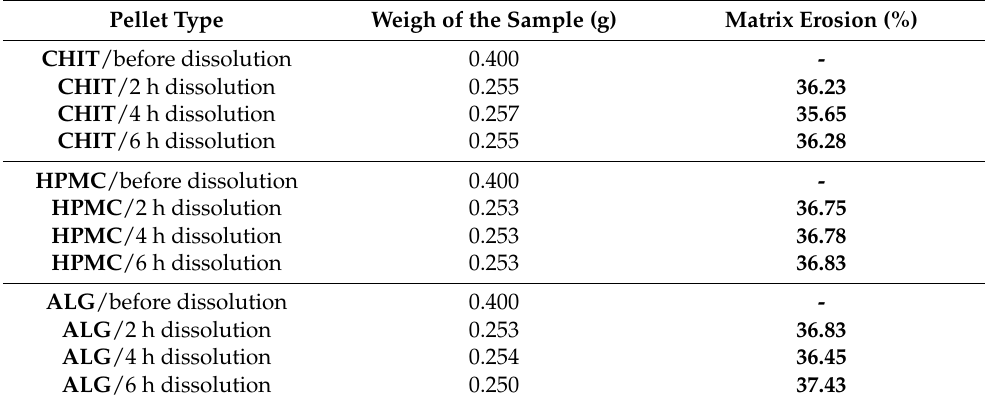
Table 5. Determination of the matrix erosion of chitosan (CHIT), hydroxypropyl methylcellulose (HPMC), and sodium alginate (ALG) pellets.